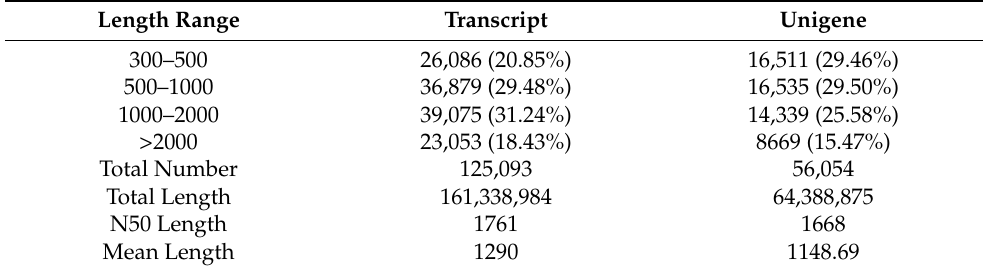
Table 1. Statistics of assembly results.